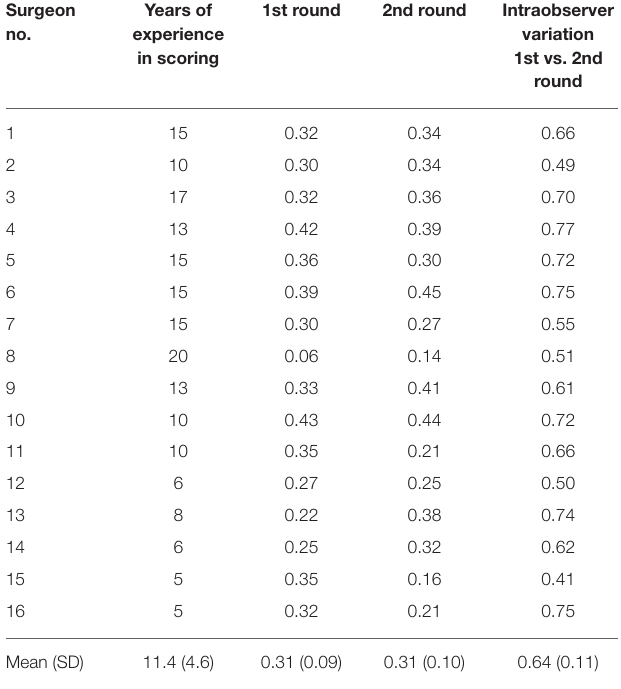
TABLE 1 | Kappa per surgeon for agreement between scoring and surgical reports in the first and second rounds and the intraobserver kappa between rounds 1 and